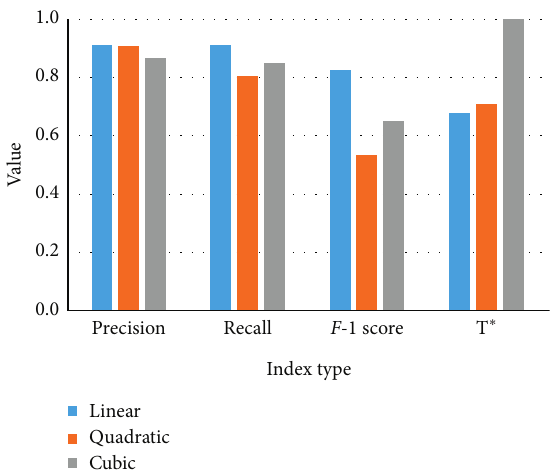
Figure 33: The percolation time of images using the 200-dataset with different stride values.